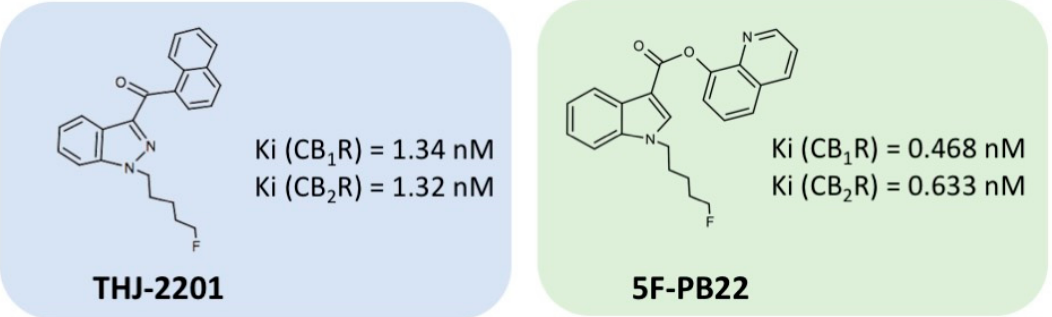
Figure 8. Structures of THJ-2201 and 5F-PB22 and respective binding affinities to the cannabinoid receptors (CBRs) type 1 and 2, according to Hess et al. [54].